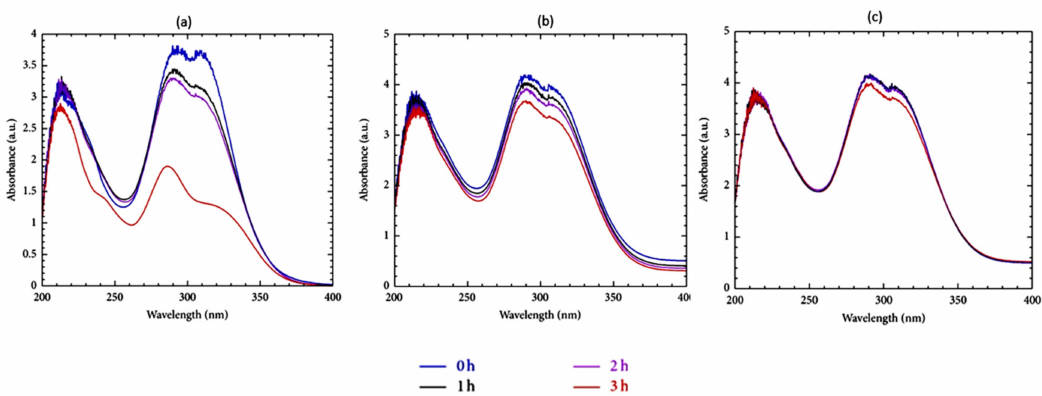
Figure 6. Change in UV absorption spectra of sunscreen sample containing a mixture of UV filters after different times of irradiation. ( a ) Free of β -CD; ( b ) 5 g β -CD; ( c ) 10 g β -CD